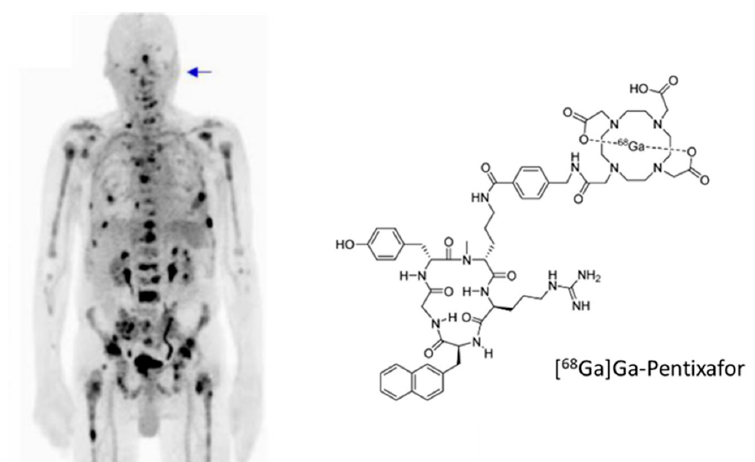
Figure 4. Structure of [ 68 Ga]Ga ‐ Pentixafor and PET MIP of a patient with multiple myeloma (modified from Wester et al., originally published in Theranostics [226]). from Wester et al., originally published in Theranostics